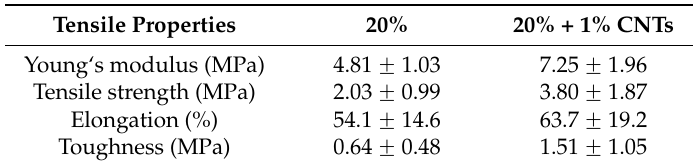
Figure 1. Typical stress-strain plots of nylon 6 non-woven fiber mats electrospun from 20 wt % nylon 6 solutions with and without 1 wt % carbon nanotubes (CNTs) suspensions. Table 1. Tensile properties of nylon 6 non-woven fiber mats electrospun from 20 wt % nylon 6 with/without CNTs .